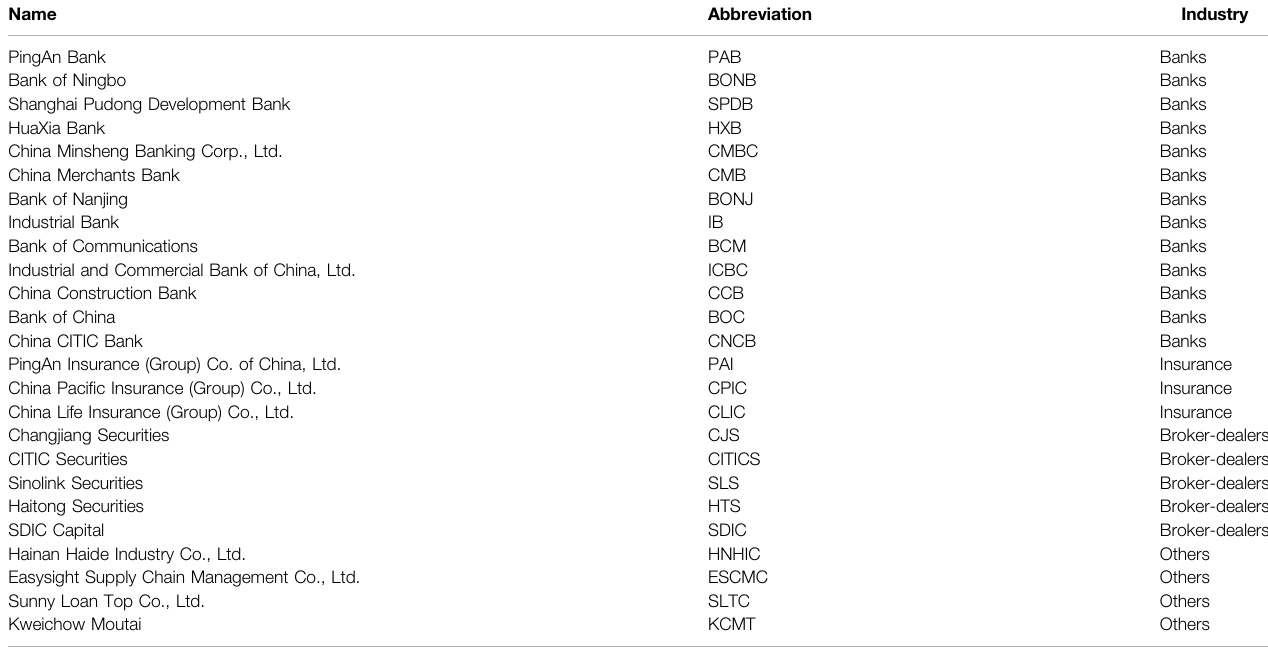
TABLE 2 | Overview of the Chinese